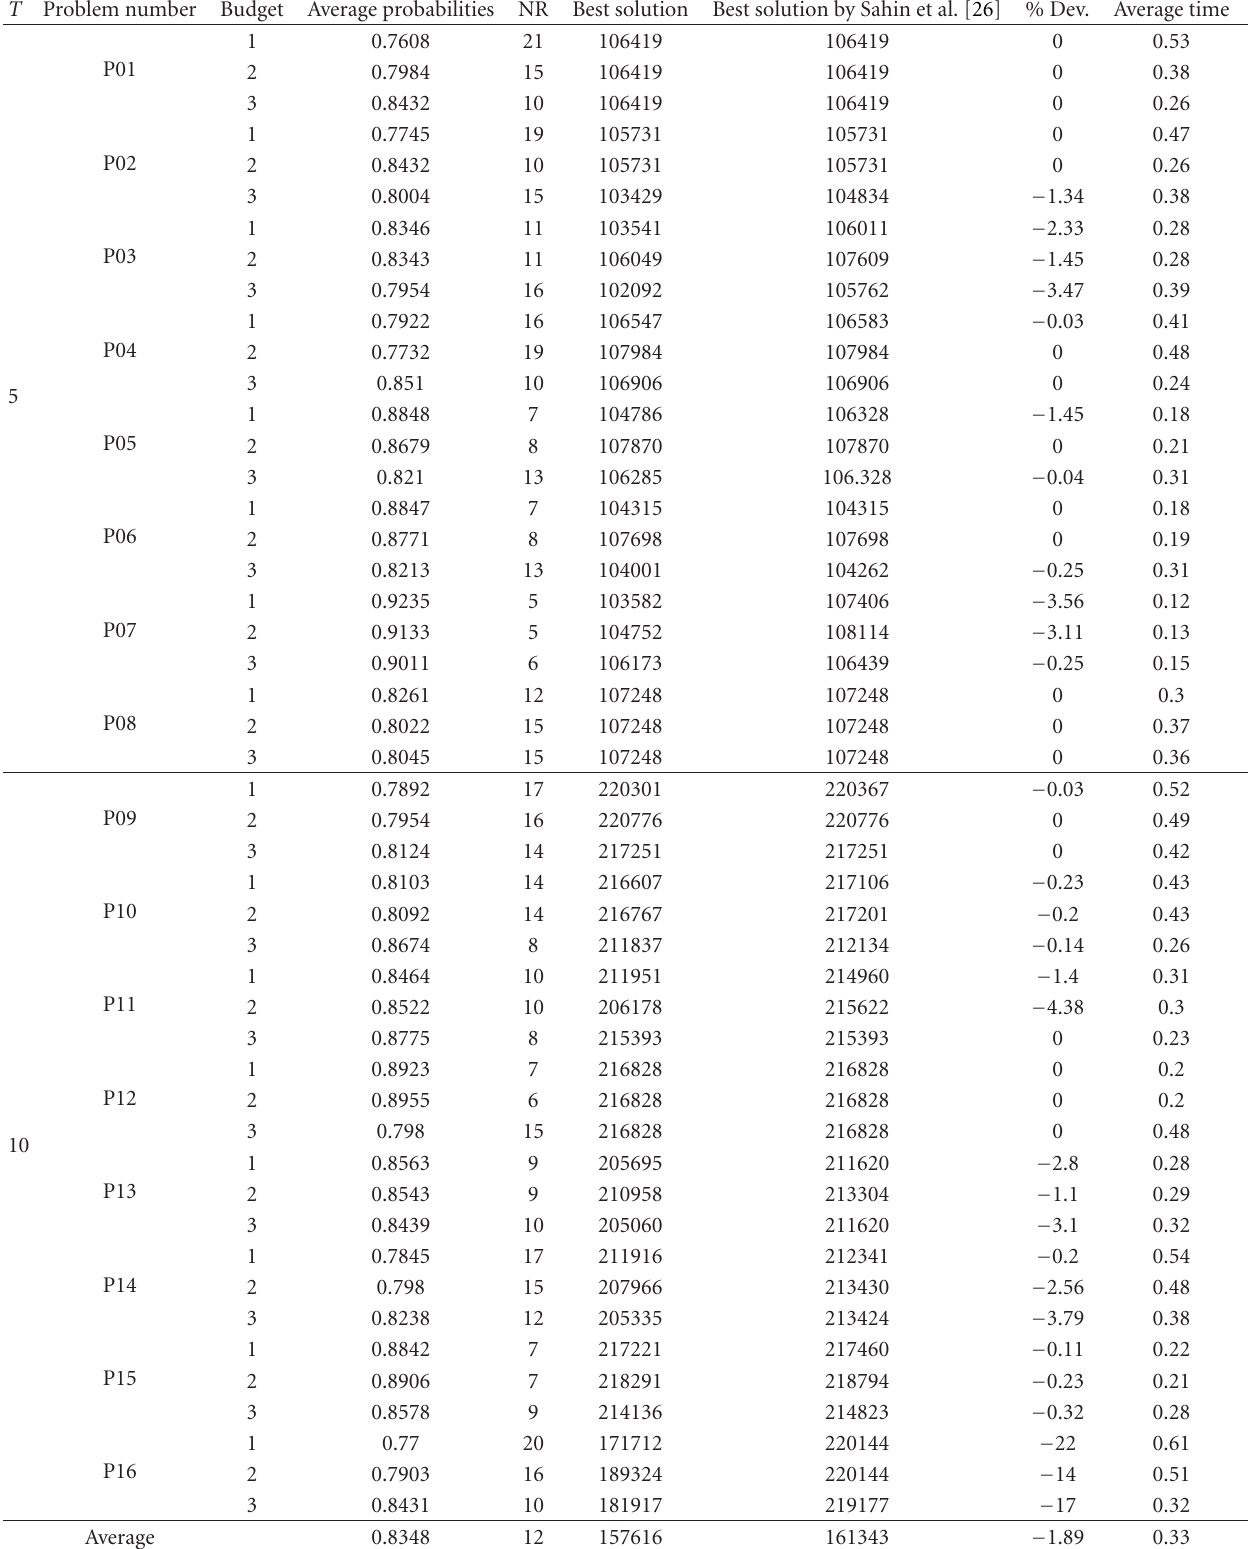
Table 1: The computational results with significant level 99% with N =